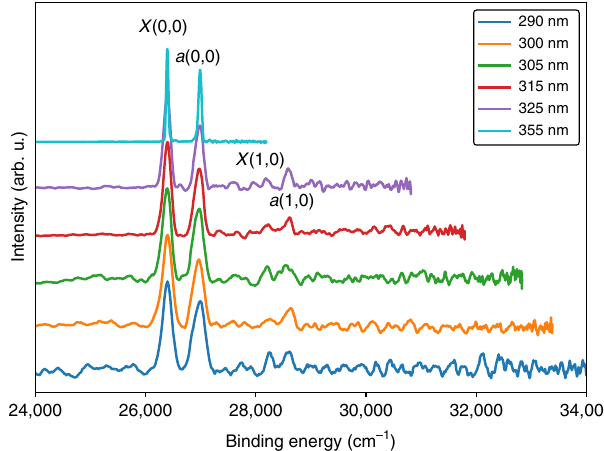
at a range (290 – 355 nm) of detachment Fig. 5 Photoelectron spectra of C (cid:1) 2 wavelengths. The vibrational origin transitions are observed for the ground X 1 Σ þ and fi rst excited a 3 Π electronic states. The OPO measurements u g (290 – 325 nm) also show the (1, 0) vibrational transition for each state